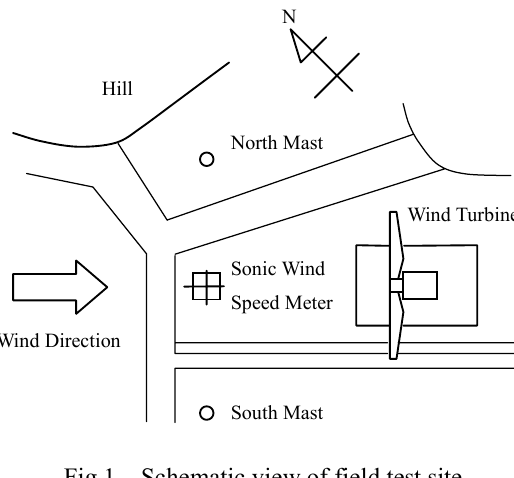
Fig.1 Schematic view of field test site